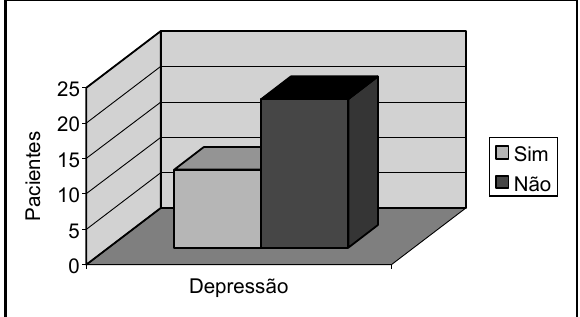
Figura 7 – Distribuição dos pacientes relacionada com a